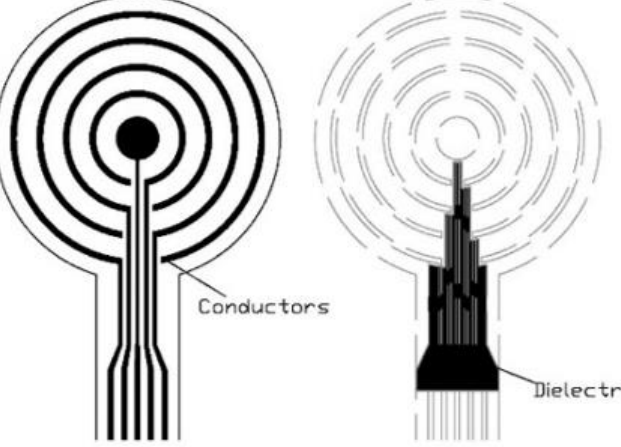
Figure 2. Bilayer design of the multi-ring concentric electrode (conductors and dielectric).